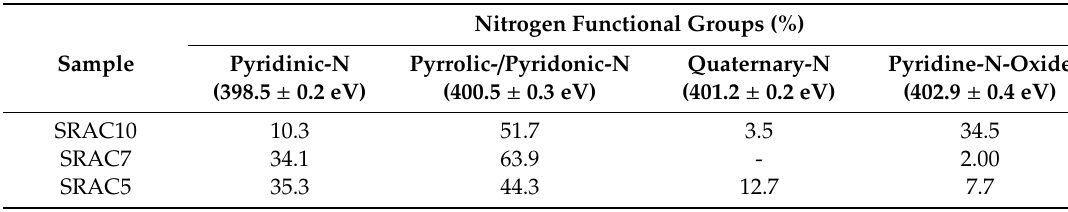
Figure 4. The high-resolution XPS N1s spectra of: ( a ) SRAC10; ( b ) SRAC7; and ( c ) SRAC5. Table 2. Peak assignment of N 1 s of